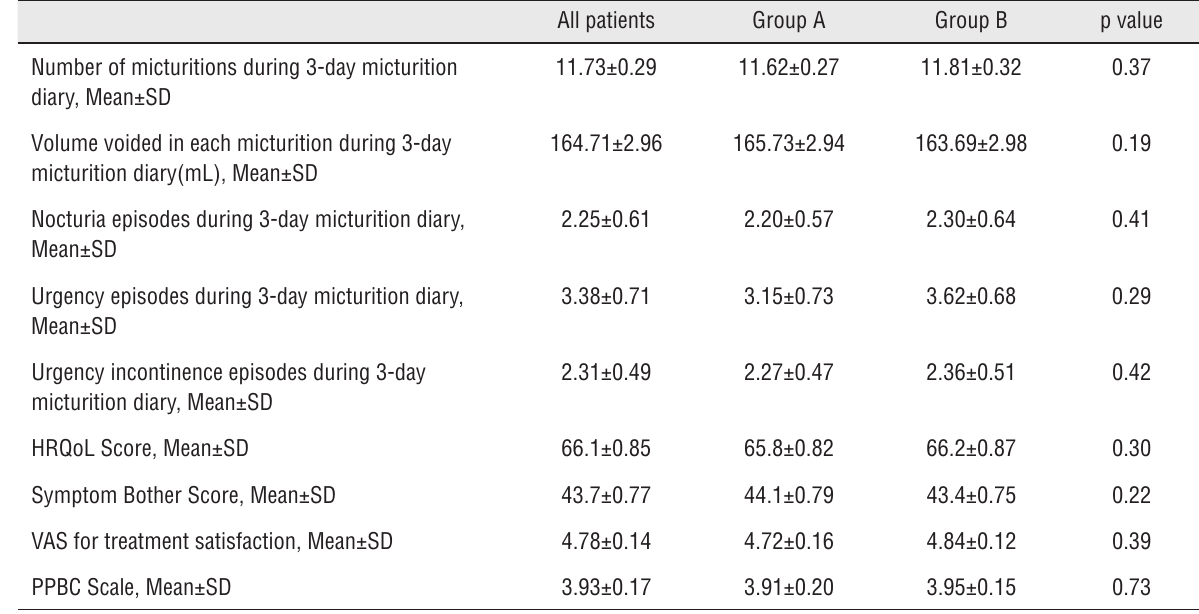
Table 2 - Parameters for Efficacy Assessment.